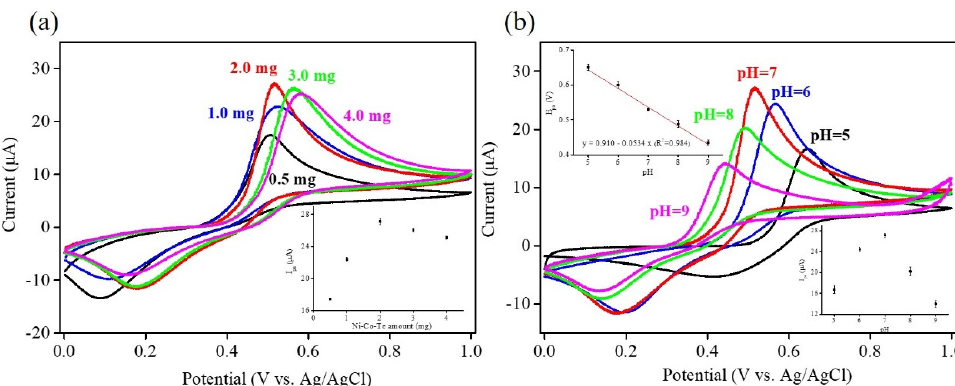
Figure 5. CV curves of Ni–Co–Te/Nafion-modified GCE with: ( a ) different amounts of Ni–Co–Te nanocomposites, and ( b ) pH in 0.1 M PBS in the presence of 1 mM acetaminophen at a scan rate of 50 mV s − 1 . Inset of Figure 5 ( a ): plot of different amounts of Ni–Co–Te nanocomposites vs. the anodic peak current (I pa ). Insets of Figure 5 ( b ): plot of pH vs. the anodic peak potential (E pa ) (upper left inset) and plot of pH vs. the anodic peak current (I pa ) (bottom right inset).